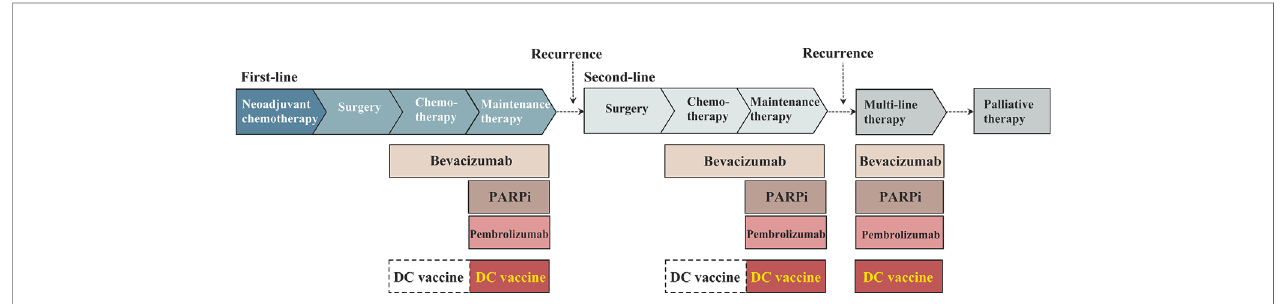
FIGURE 2 | The schema of dendritic cell (DC)-based vaccine in the maintenance treatment in ovarian cancer.